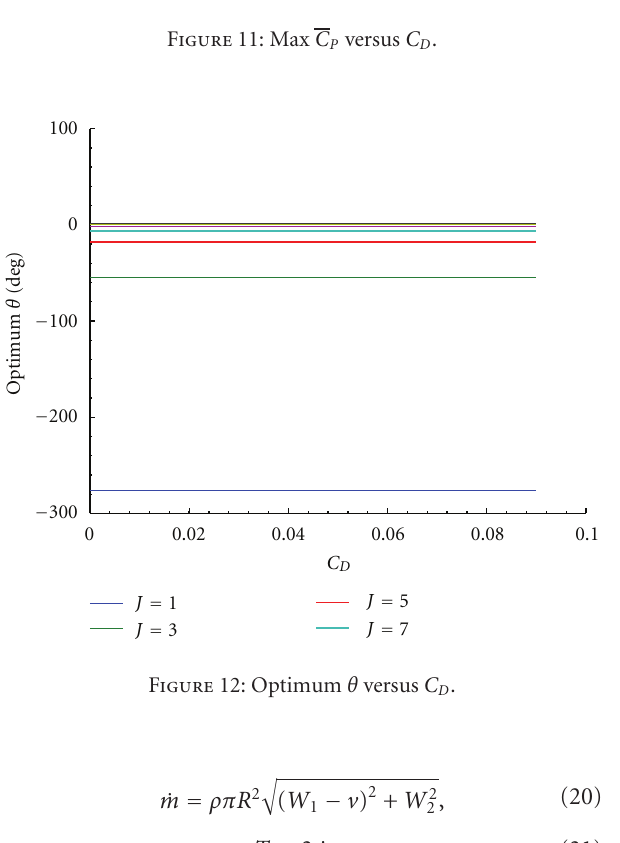
Figure 11: Max C P versus C D .